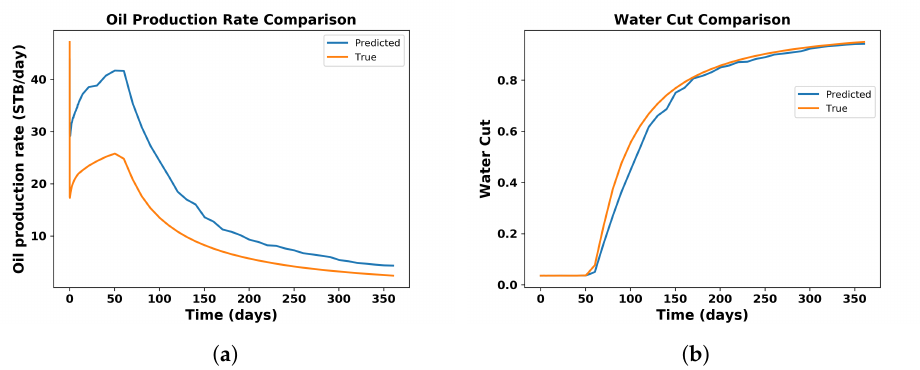
Figure 12. Quantities of Interest comparison ( a ) Oil production rate and ( b ) Water cut.